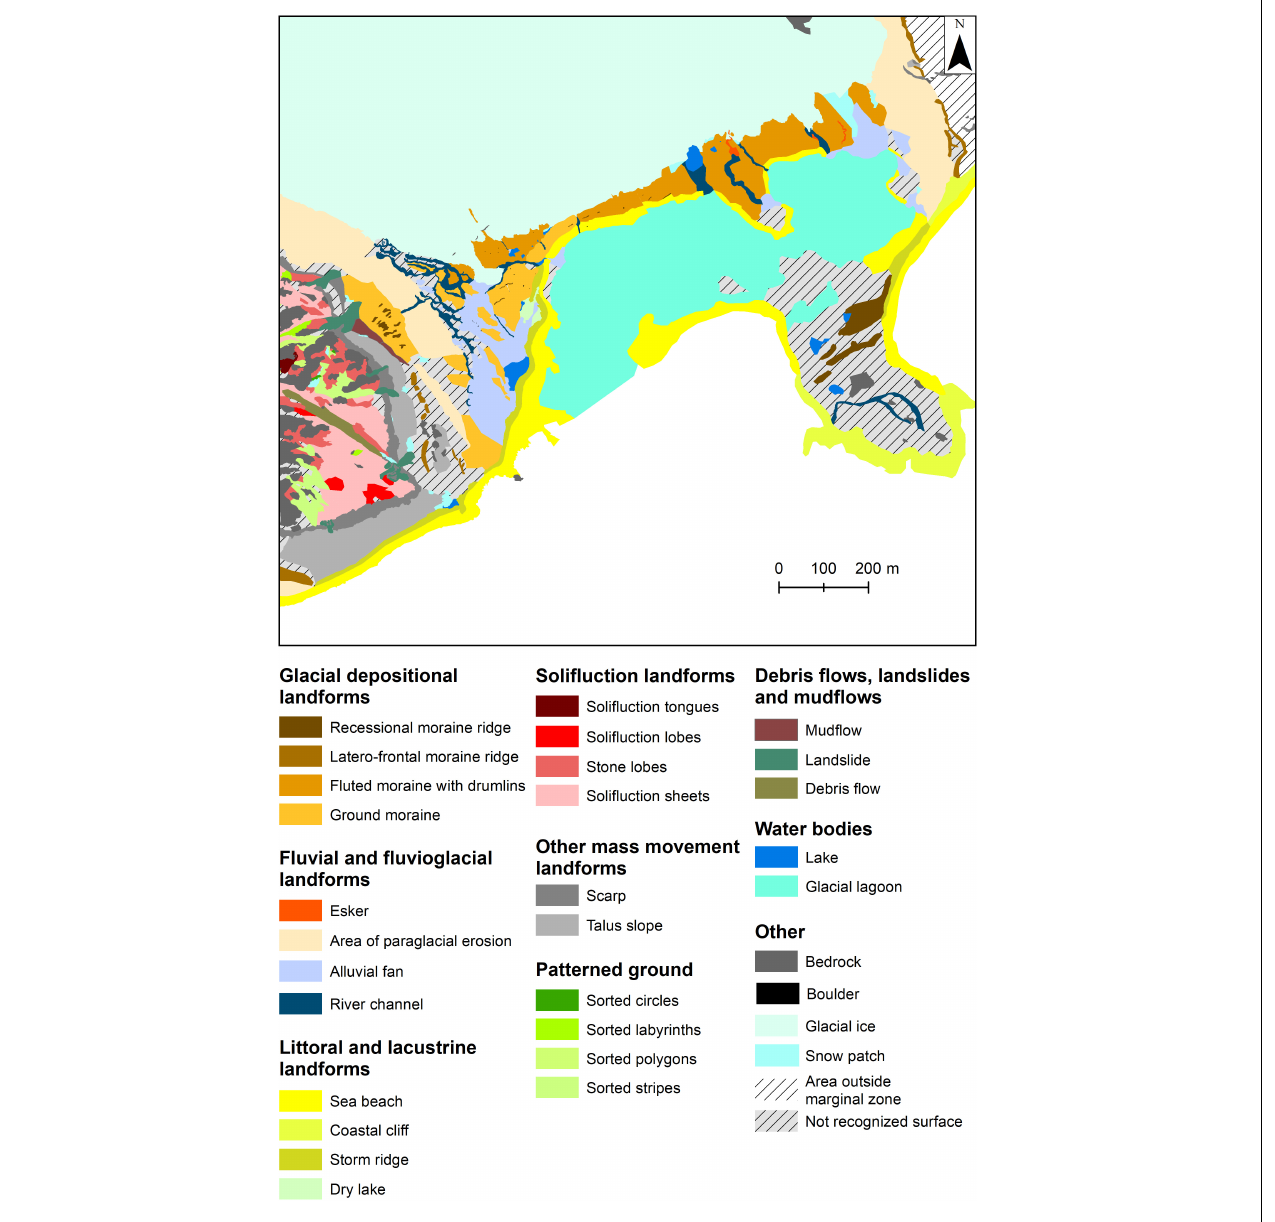
FIGURE 3 | Geomorphological map of Windy Glacier foreland and east side of Red